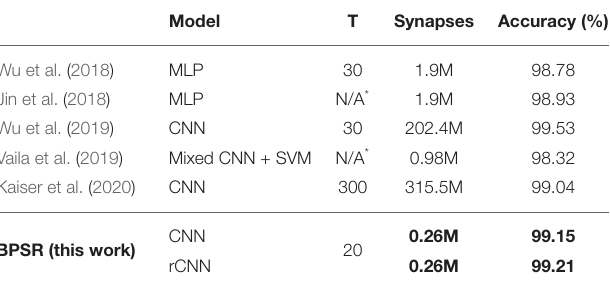
TABLE 4 | Comparison of different spiking models on N-MNIST dataset. TABLE 5 | Comparison of different spiking models on CIFAR10 dataset.